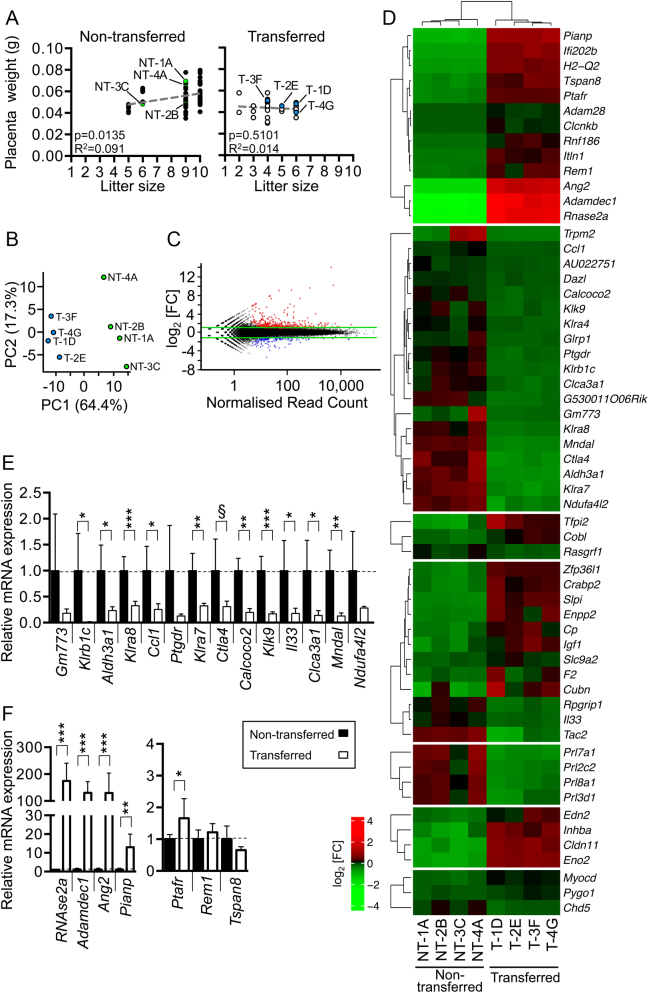
Blastocyst transfer causes differential gene expression in mouse placentas at E10.5. An RNA-seq analysis was performed on whole male placentas from non-transferred and transferred experimental groups. n = 4 placentas from 3 to 4 litters per group were analysed. Placentas assessed via RNA-seq are labeled in panels A, B, C and D with the placenta ID (non-transferred (NT) or transferred (T) followed by the sample number and letter ID indicating the litter). (A) Graphs plotting litter size versus placental weight of male and female non-transferred placentas (left panel) and transferred placentas (right panel). The line of best fit (grey dotted line) is indicated, and the P and R2 values from a linear regression analysis are shown. Green and blue data points are samples used in the RNA-seq experiment. (B) Principal component analysis of the RNA-seq data of whole male placentas from control non-transferred (green circles) and transferred (blue circles) conceptuses. (C) MA plot revealing 543 differentially expressed genes (DEGs) with a fold change > log21.0 (i.e., fold change ≥ 2; P < 0.05) in placentas from transferred conceptuses compared to non-transferred controls. 188 DEGs were downregulated (blue) and 355 DEGs were upregulated (red). (D) Heat map showing differential expression of selected DEGs in non-transferred (NT) and transferred (T) placentas. Scale shown is log2(fold change). Red, gene upregulation; green, gene downregulation. (E and F) Validation of RNA-seq data by qRT-PCR analysis in independent placentas from non-transferred (black bars) and transferred (white bars) conceptuses. Data are presented as fold change compared to controls (normalised to 1). n = 4–7 placentas per group from 2 to 4 litters. Graphs show qRT-PCR data of representative genes that were significantly (E) downregulated or (F) upregulated in transferred placentas. Unpaired t tests with Welch correction or Mann–Whitney tests where appropriate, §P = 0.05, *P < 0.05, **P < 0.01, ***P < 0.001.